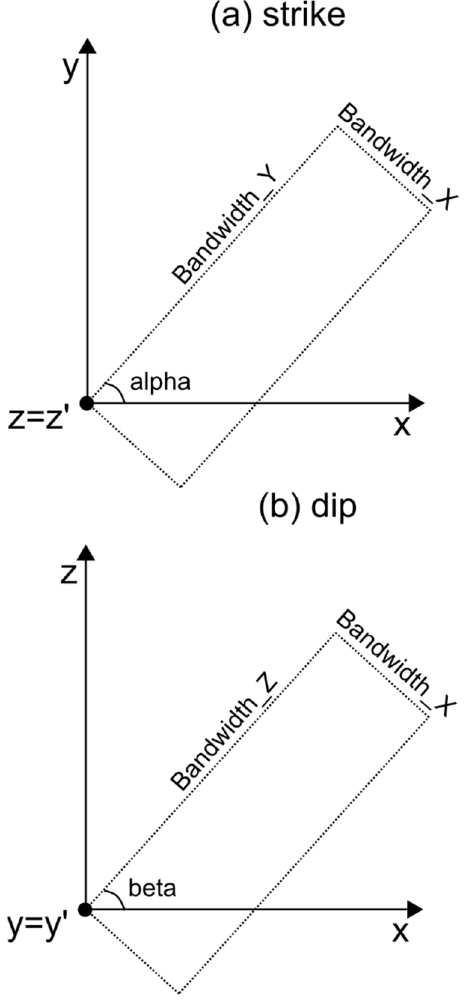
Figure 2. Angles and size (‘bandwidth’) that define the directional shape of the searching box used to compute local geological entropy.